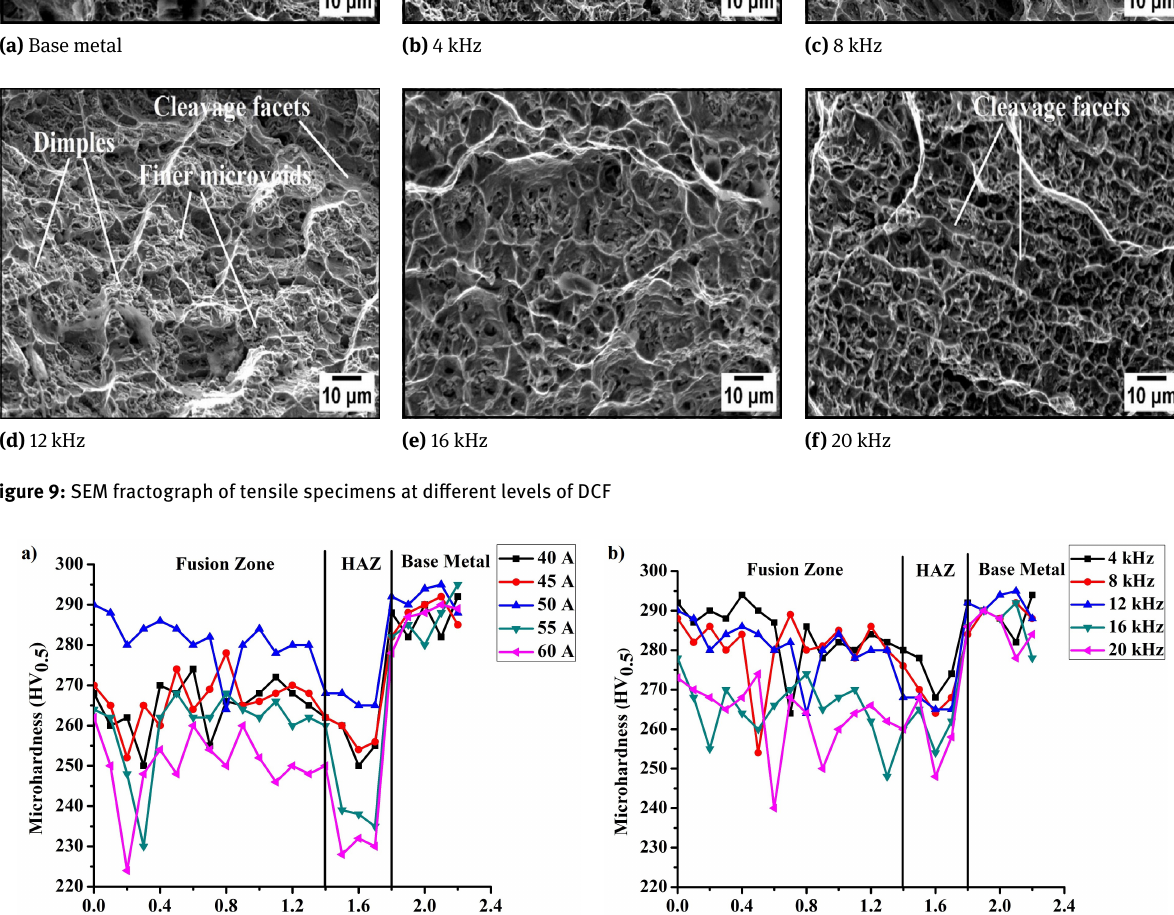
ture. The joints welded at 50 A DC and up to 12 kHz DCF showed a comparatively reduced microhardness gradient as compared to the higher levels of DC and DCF. However, lower microhardness values were observed in the fusion zone. These are the regions which are mainly responsi- ble for the failure of the welded joints in the fusion zone. The microhardness gradient in the fusion zone is higher at incremental levels of DC and DCF. It is attributed to the